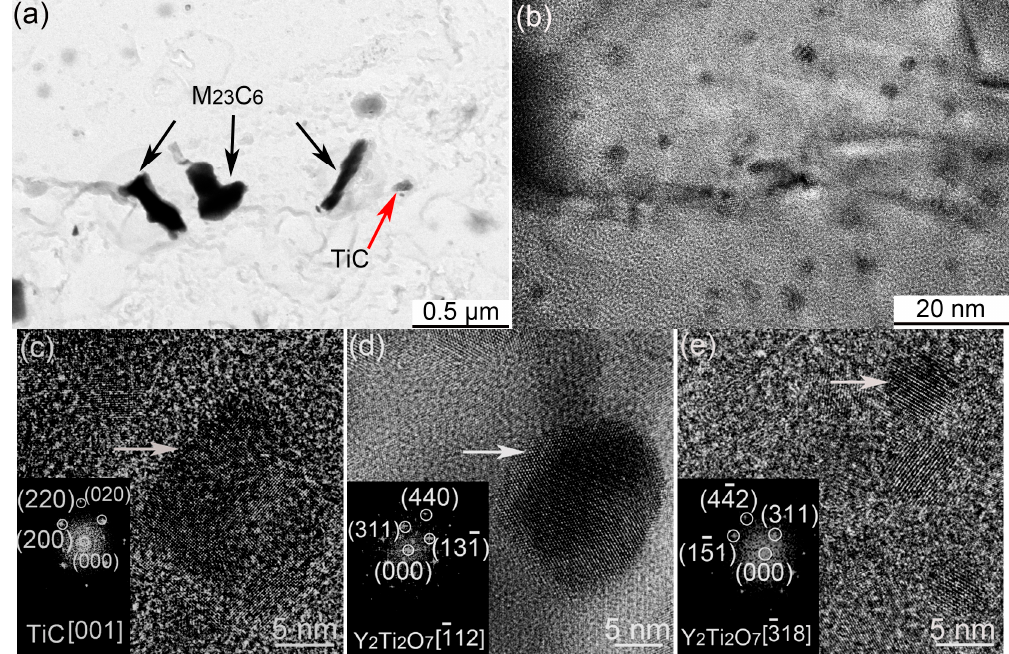
Figure 14. Secondary phases in the ODS steel: ( a ) M 23 C 6 particles; ( b ) distribution of nanoparticles; ( c – e ) HRTEM images of nanoparticles and the corresponding FFT patterns.